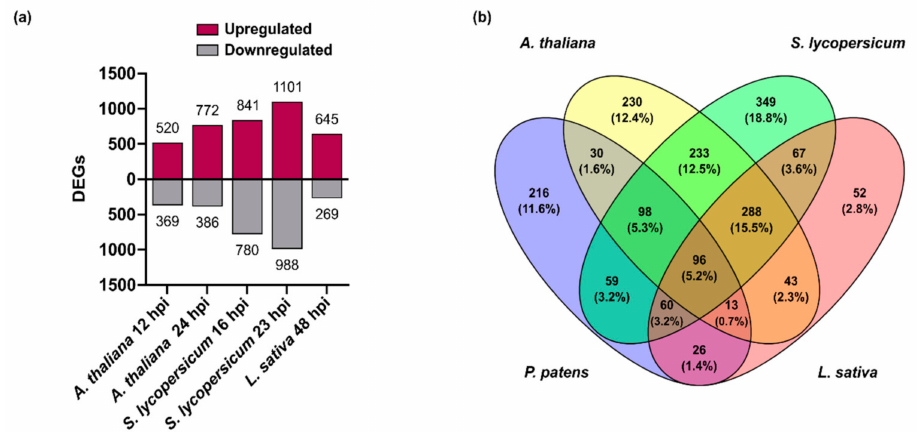
Figure 4. Differentially expressed B. cinerea genes during P. patens and angiosperms infection. ( a ) Number of differentially expressed genes (DEGs) from B. cinerea grown in different plant species at the indicated time points. ( b ) Venn diagram of B. cinerea upregulated DEGs in different plant species, showing overlap of upregulated fungal genes. P. patens : B. cinerea DEGs at 8 and 24 hpi; A. thaliana : B. cinerea DEGs at 12 and 24 hpi; S. lycopersicum : B. cinerea DEGs at 16 and 23 hpi; and L. sativa : B. cinerea DEGs at 48 hpi. For the Venn diagram, DEGs had log2 FC ≥ 2, FDR ≤ 0.05, and were expressed differentially in at least one time point for each plant species